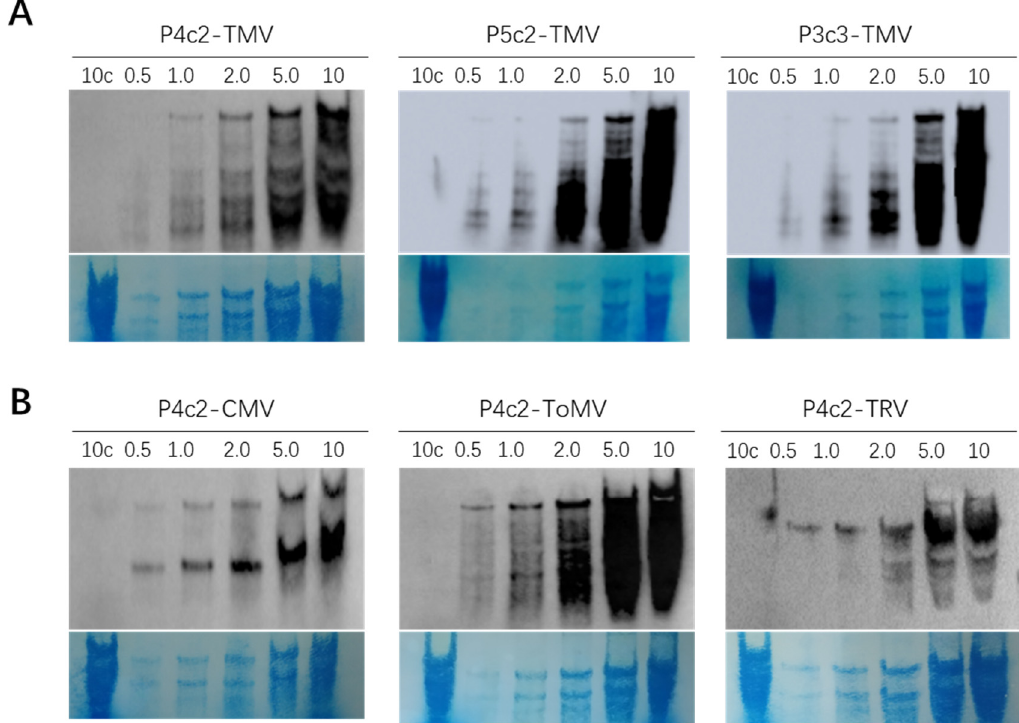
Figure 5. Detection of different viral hmwRNAs using new Northern blot protocol. ( A ) TMV blots hybridized using probes attached to different G repeats. ( B ), CMV-, ToMV-, and TRV-infected samples were analyzed with probes indicated above each blot. The first lane in each blot was loaded with a 10 µ g total RNA sample from uninfected samples, indicated as 10c; in all other lanes, the same virus-infected sample was loaded with the amount indicated on top of each lane in μ g.